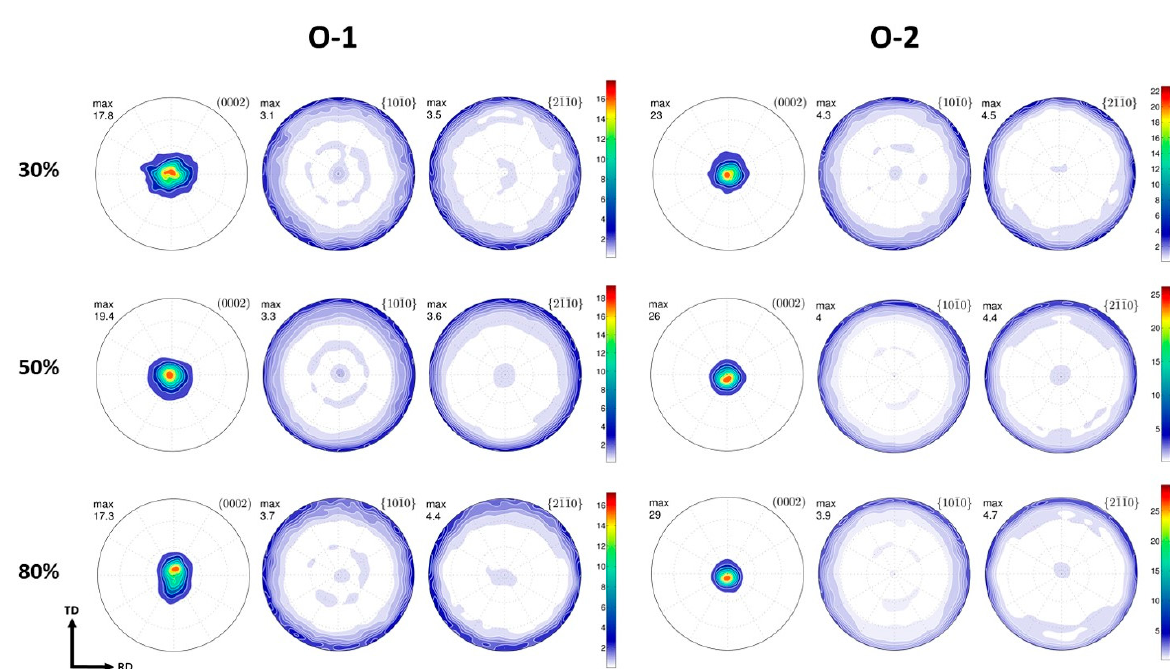
Figure 4. Pole Figures of texture measurements of magnesium sheets at different thickness reductions for both orienta- tions.